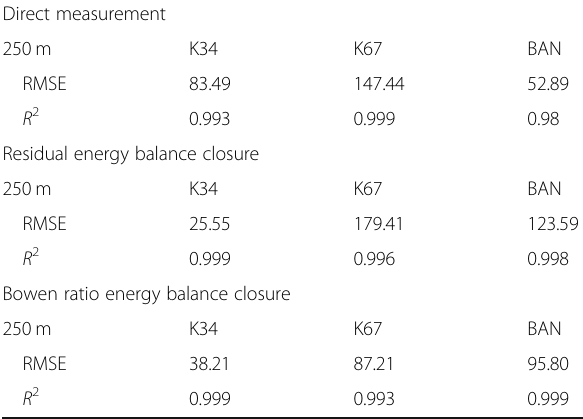
Table 4 The RMSE and R 2 metrics used to validate ET-Amazon for integration periods of 2 months or longer. A footprint of one pixel is